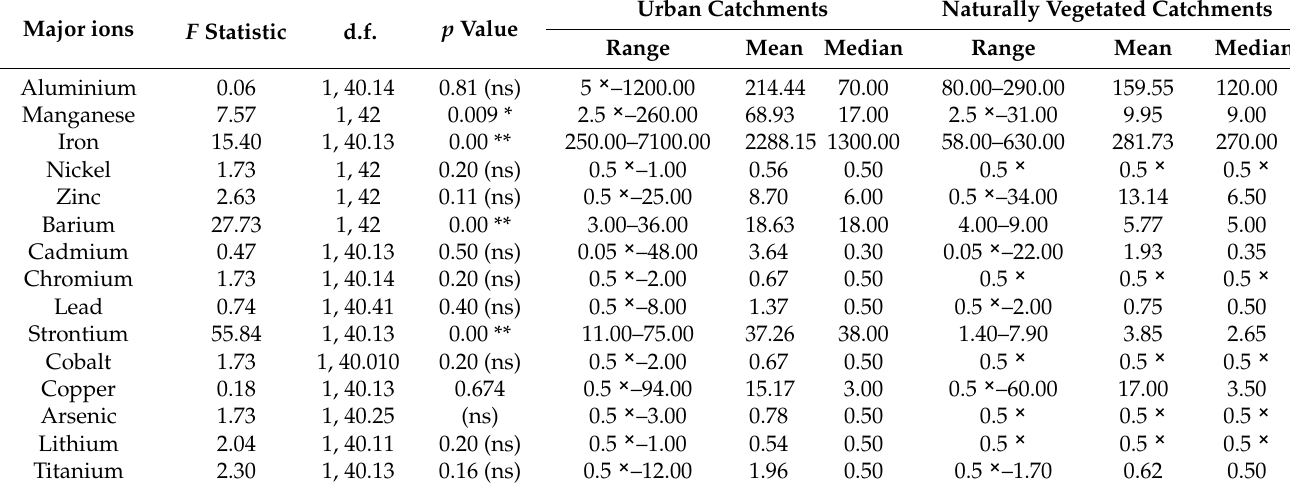
denotes values that were below the detection limit. d.f. denotes the degrees of freedom (numerator, denominator).